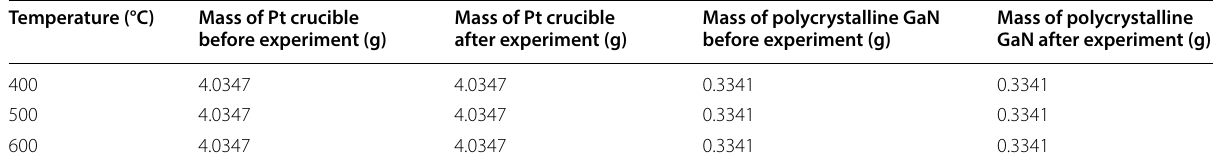
Table 4 Mass of platinum (Pt) crucible and polycrystalline gallium nitride (GaN) before and after heating for 100 h under a nitrogen atmosphere Temperature (°C)